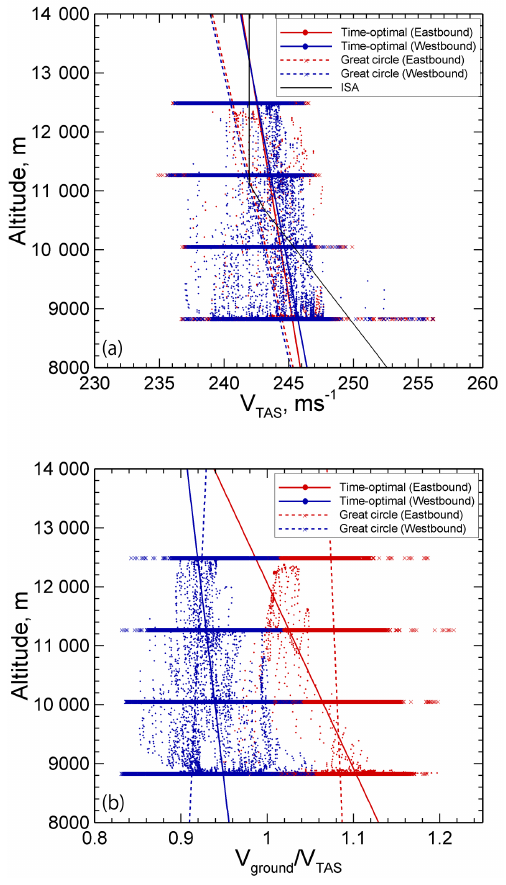
Figure 18. Values of the true air speed V TAS (a) and the tail wind indicator V ground /V TAS (b) at waypoints for the time-optimal and great circle flights. Linear fits of the time-optimal (solid line, red (eastbound) and blue (westbound)) and great circle cases (dashed line, red (eastbound) and blue (westbound)) are included. V TAS of the international standard atmosphere (ISA) is given in (a) (solid line, black) provided by the BADA atmosphere table (Eurocontrol, 2010).